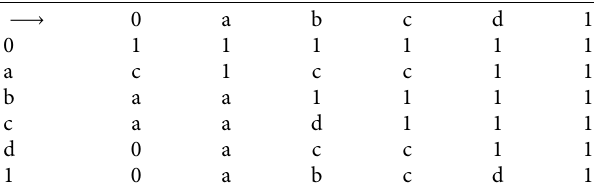
Table 2: Cayley table of implication.